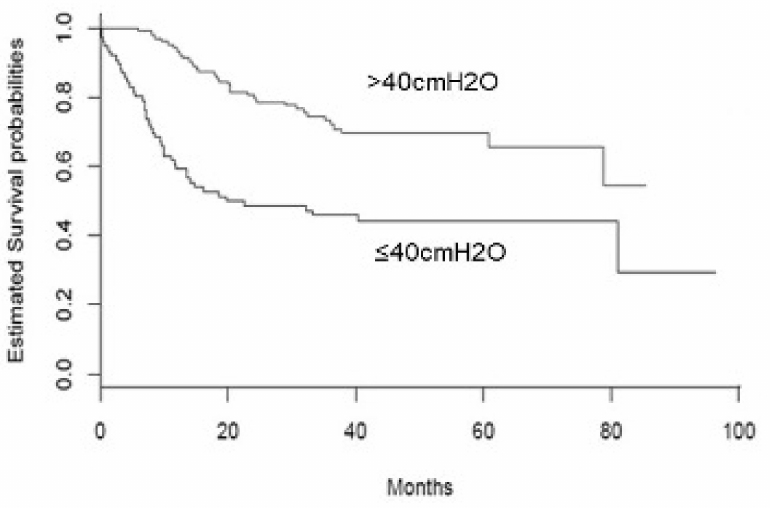
Figure 1. Kaplan–Meyer survival curves of ALS cases stratified according to SNIP value ( ≤ 40cmH 2 O vs. >40cmH 2 O).